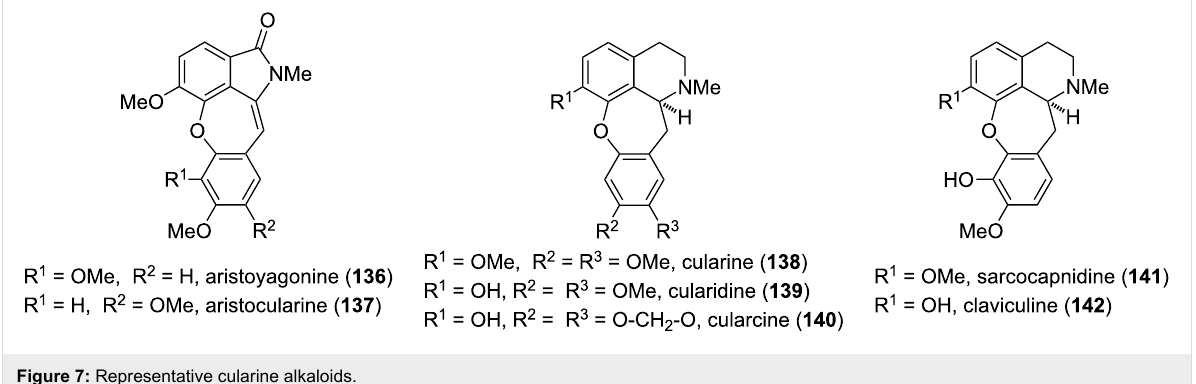
Figure 7: Representative cularine alkaloids.